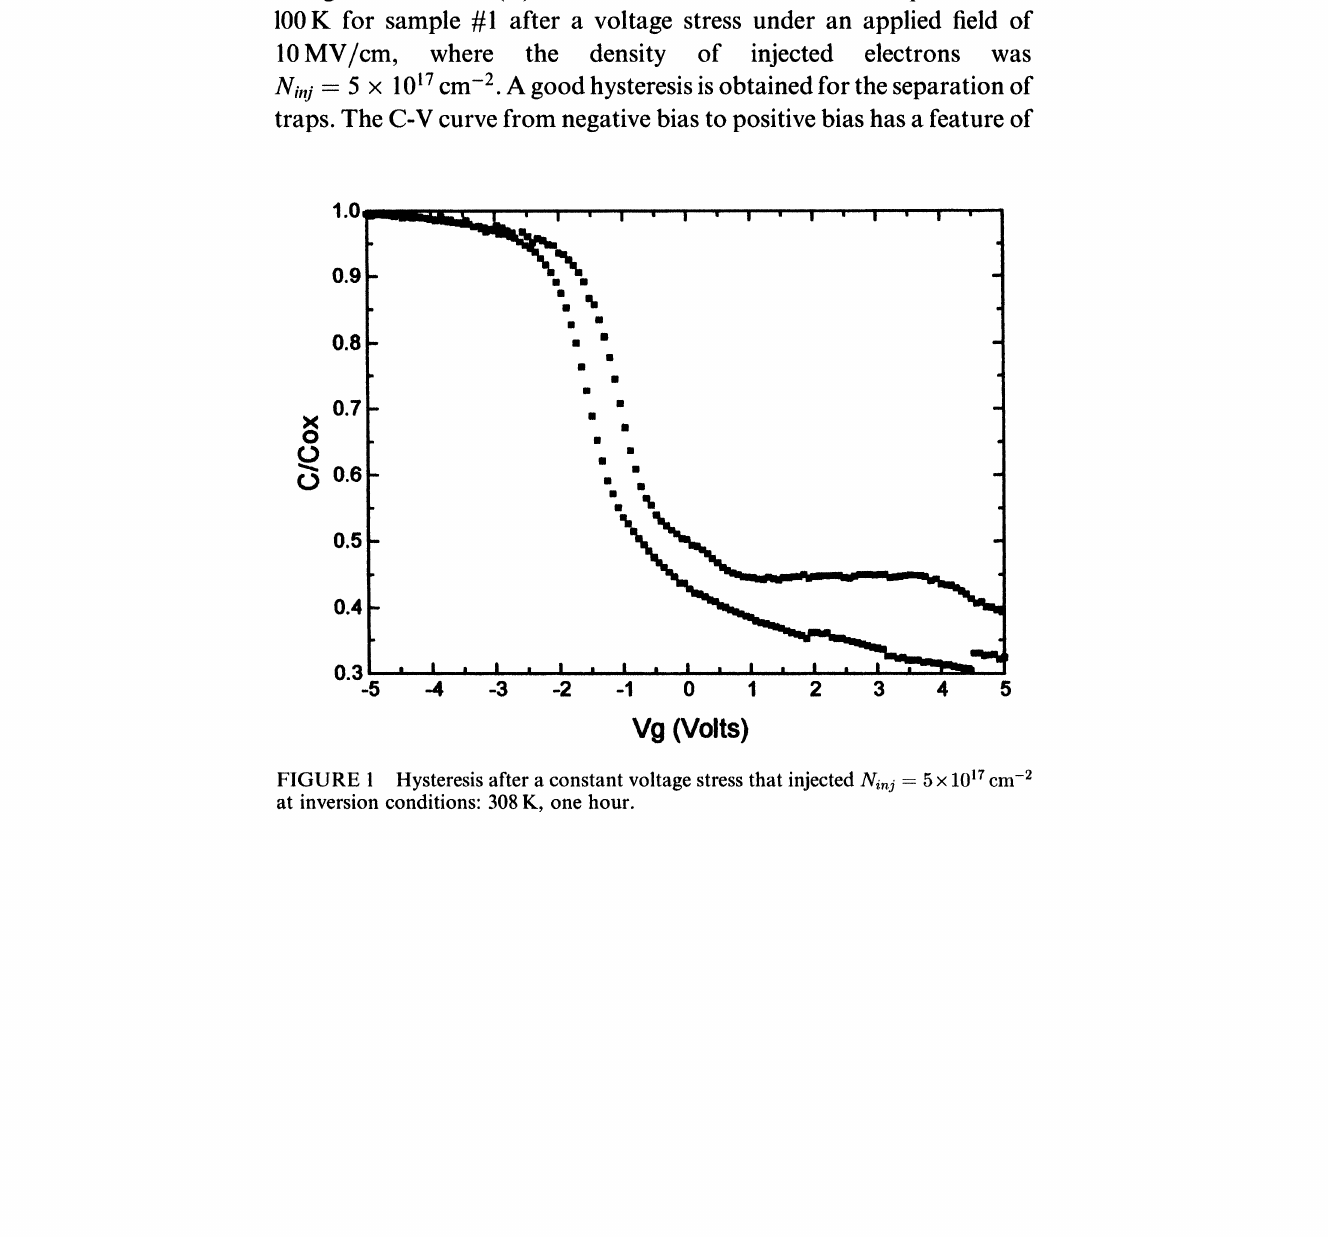
Figure shows C(V) characteristics measured at a temperature of 100 K for sample #1 after a voltage stress under an applied field of 10MV/cm, where the density of injected electrons was Ni,j 5 1017 cm -2. A good hysteresis is obtained for the separation of traps. The C-V curve from negative bias to positive bias has a feature of 1.0